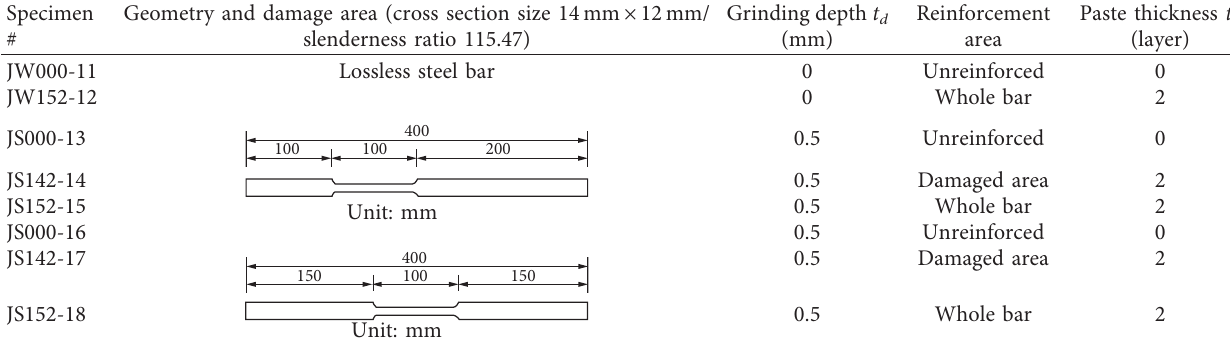
Table 1: Damage and reinforcement of steel specimens in Group 1.